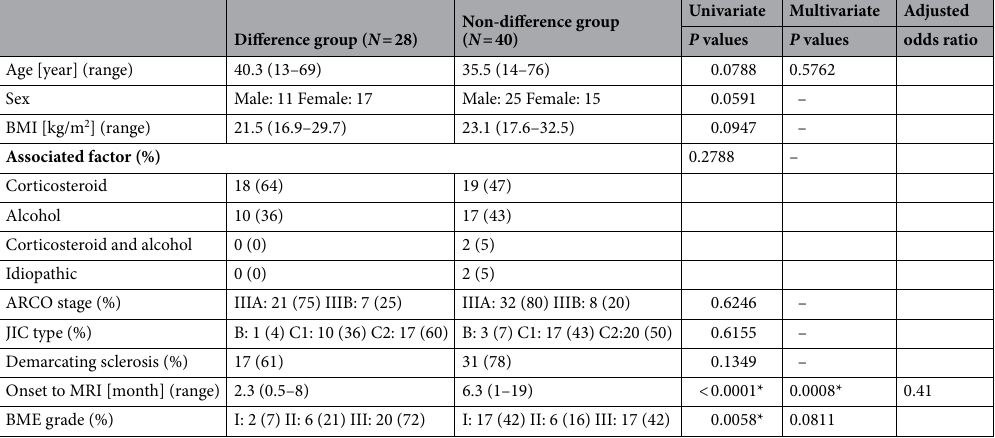
Table 1. Univariate and multivariate analyses for coronal plane in the difference in the boundary of necrotic lesion group and the non-difference in the boundary of necrotic lesion group, comparing unenhanced and contrast-enhanced T1-weighted MR images. BMI body mass index, MRI magnetic resonance imaging, ARCO association research circulation osseous, JIC Japanese investigation committee, BME bone marrow edema. * P < 0.05 indicates significance.